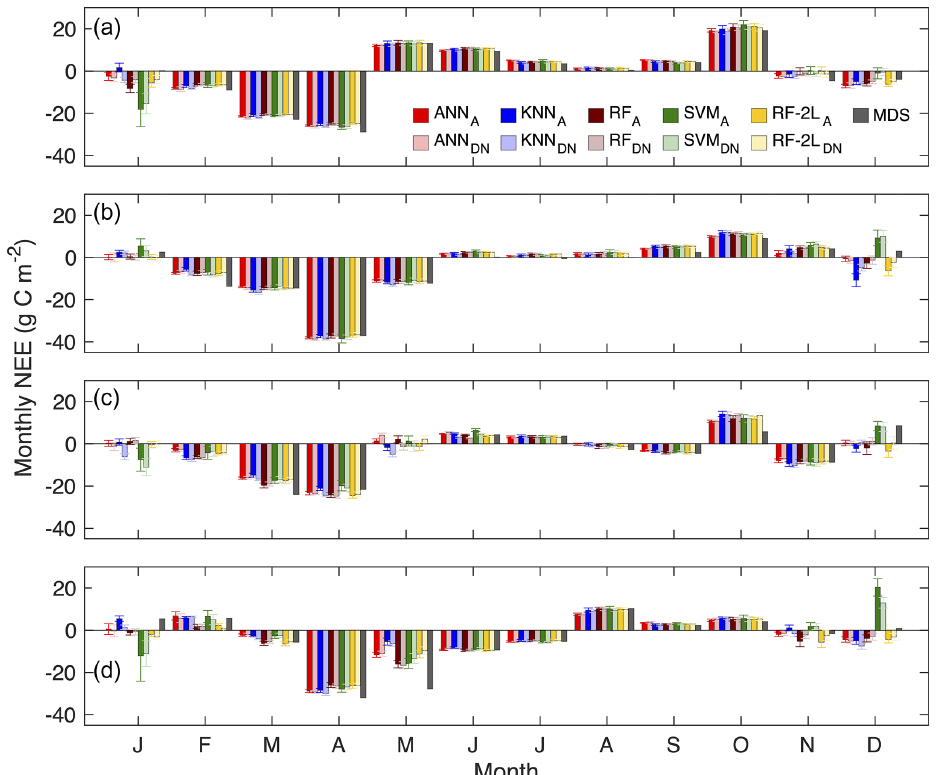
Figure 6. Monthly total net ecosystem exchange (NEE, gCm − 2 ) at the US-Hn1 in (a)–(d) 2016–2019. The subscript A denotes that the daytime and nighttime NEE data are gap-filled together using the ML algorithms trained with all the data, and DN denotes that the daytime and nighttime data are gap-filled separately and then combined to determine the monthly total values. RF-2L denotes the proposed two-layer RF-based gap-filling framework, and MDS is the marginal distribution sampling algorithm. The error bar denotes 1 standard deviation of the monthly total NEE of the 40 gap-filled time